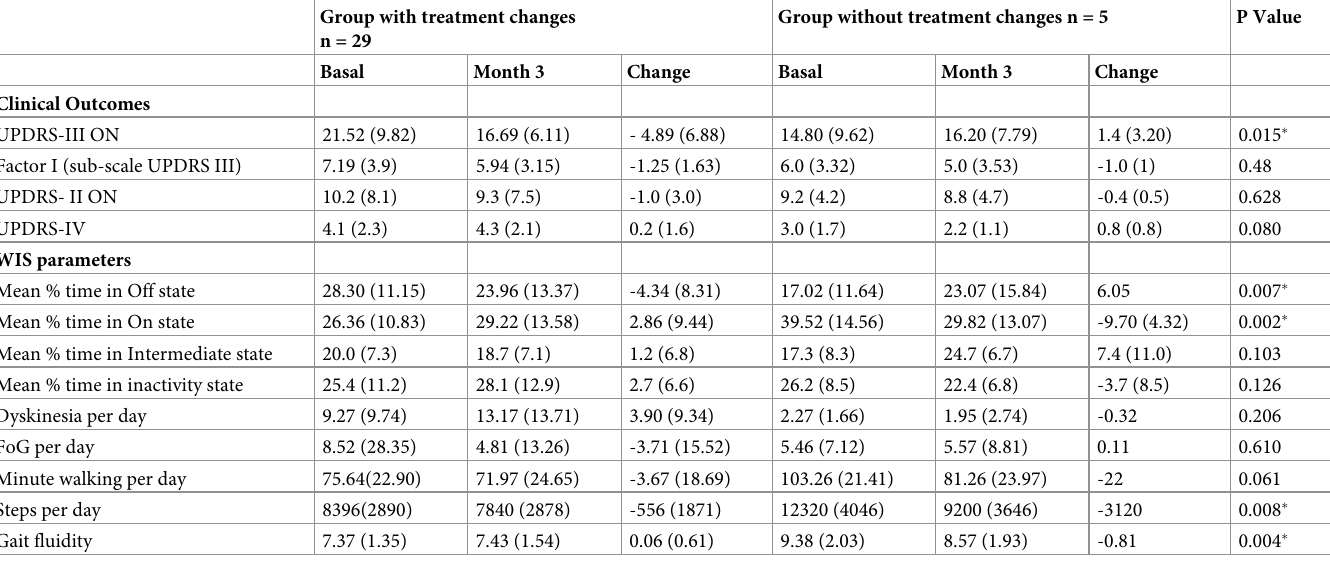
Table 4. Comparisons of the observed changes in WIS parameters between the two groups (treatment changes vs not) at baseline and after 3 months. Group with treatment changes Group without treatment changes n = n = 29